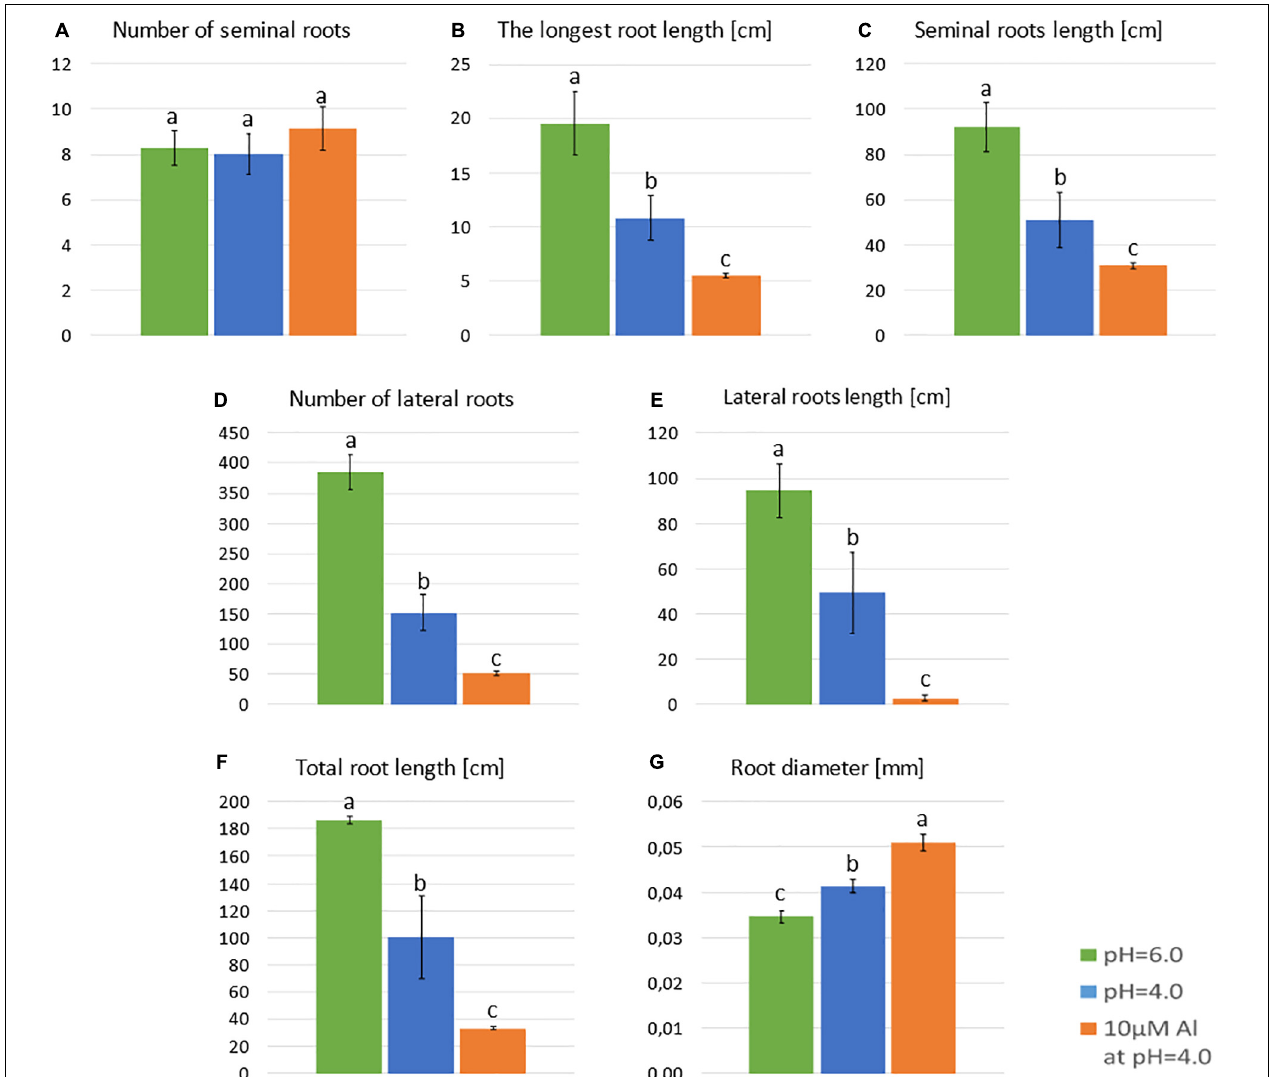
FIGURE 3 | Main parameters of ‘Sebastian’ roots after 7 days growth in hydroponics in Magnavaca medium at pH = 6.0, pH = 4.0, and with 10 µ M of bioavailable Al 3 + ions at pH = 4.0. (A) The number of seminal roots per plant. (B) The length of the longest seminal root. (C) Total length of seminal roots. (D) The number of lateral roots per plant. (E) The length of all lateral roots. (F) The summary length of the whole root system (seminals + laterals). (G) The average diameter of roots. Statistical analyses were performed using ANOVA ( P < 0.05) followed by Tukey’s honestly significant difference test (Tukey HSD test, P < 0.05). Significant differences are indicated by different